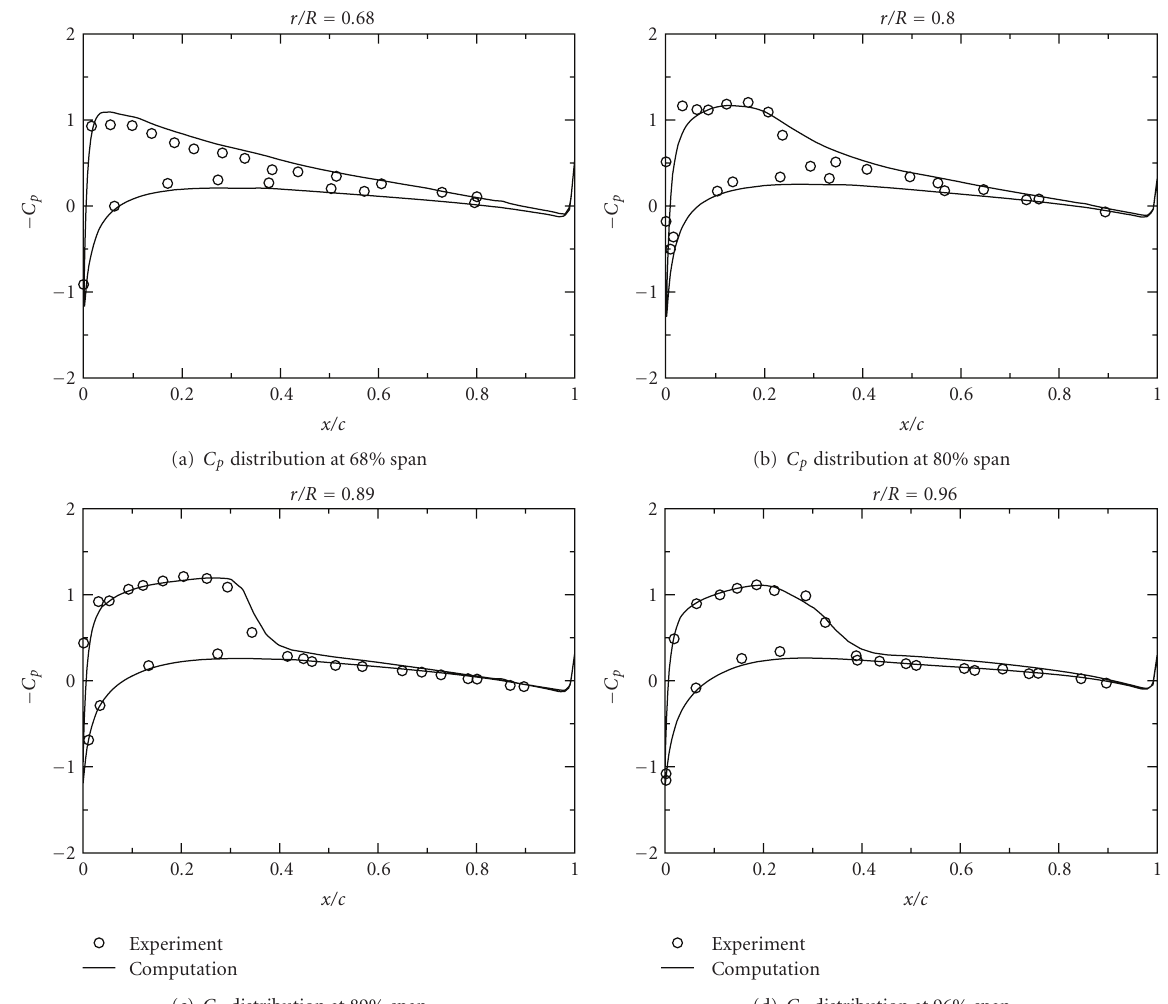
Figure 14: Computed and measured pressure coe ffi cients at di ff erent blade